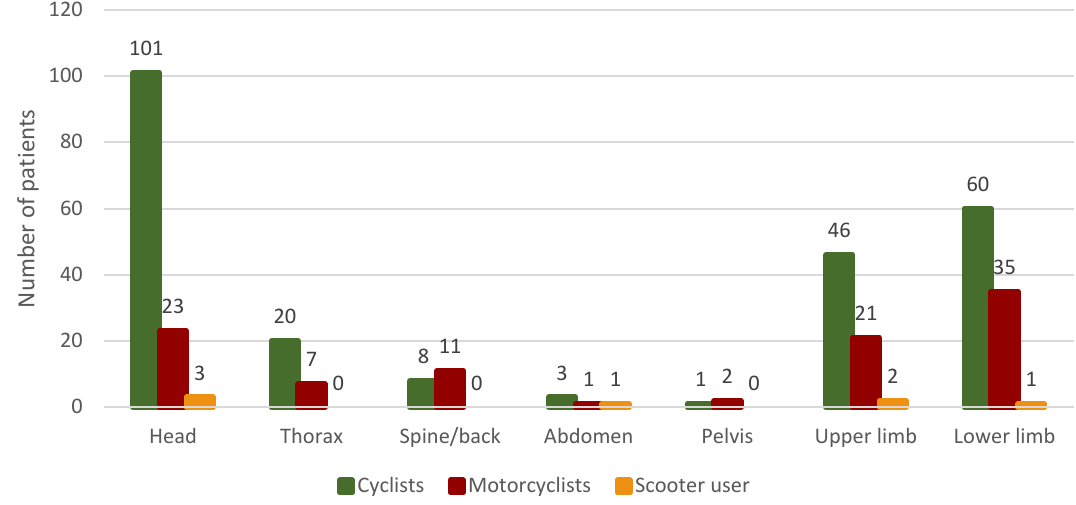
Figure 3. Patients’ injuries, taking into account types of vehicles.